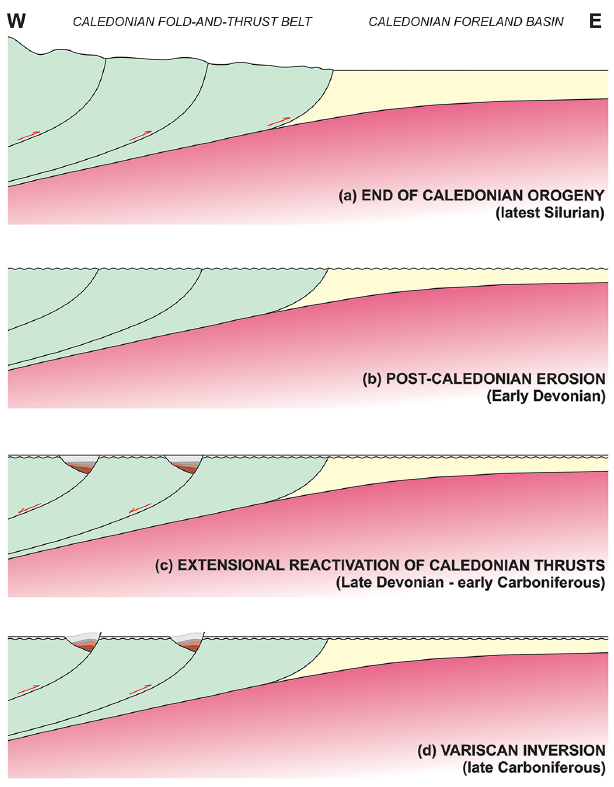
Figure 9. Regional conceptual model showing four main stages of Palaeozoic tectono-stratigraphic evolution of northern